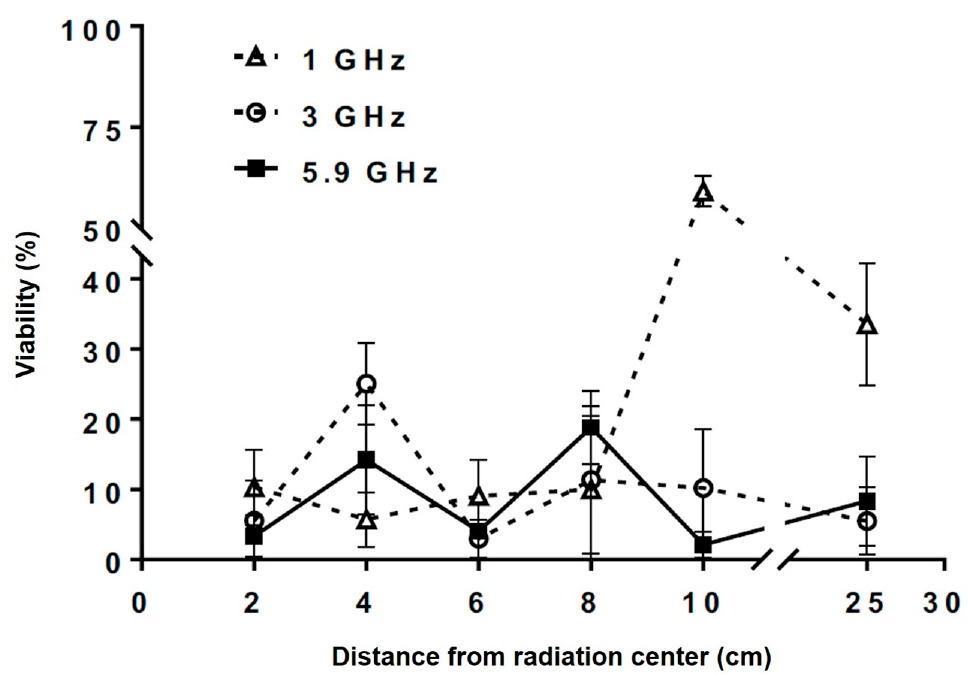
Figure 2. S. cerevisiae viability after 15 min of exposure to 1 GHz (striped line/white triangles), 3 GHz (striped line/white circles), and 5.9 GHz (black line/black squares) at different distances from the antennas. The gaps in both axes represent changes in the scales.